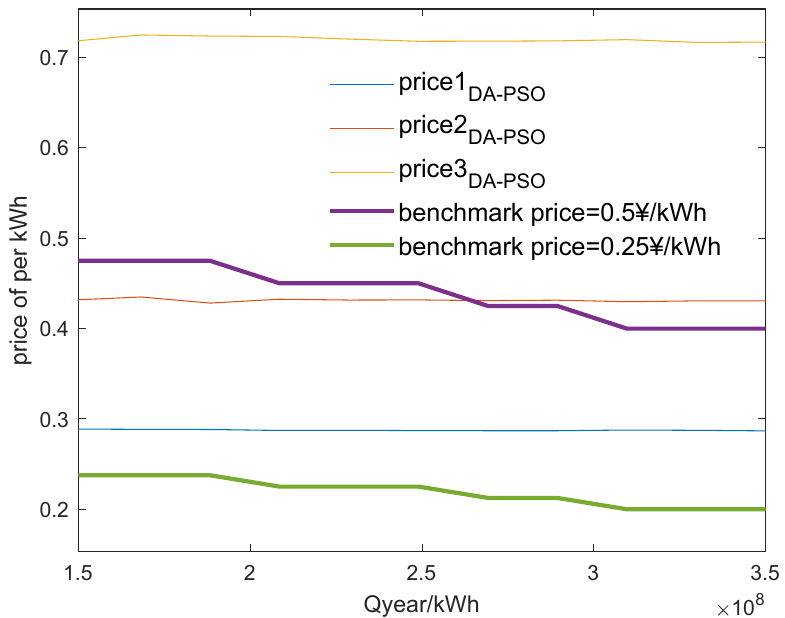
Figure 25. Itemized electricity cost and total electricity cost (medium- and long-term benchmark electricity price: RMB 0.25 /kWh).